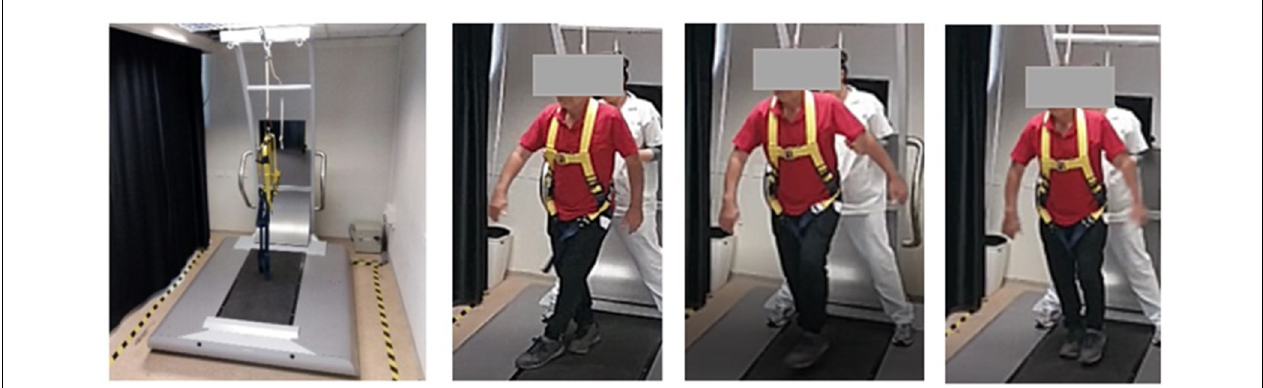
FIGURE 1 | Setup for reactive balance control assessment. On the left is the computerized treadmill system. On the right is a video sequence demonstrating reactive step response to lateral surface translation of a stroke patient with right hemiparesis. A written informed consent was obtained from the individual for the publication of this image.